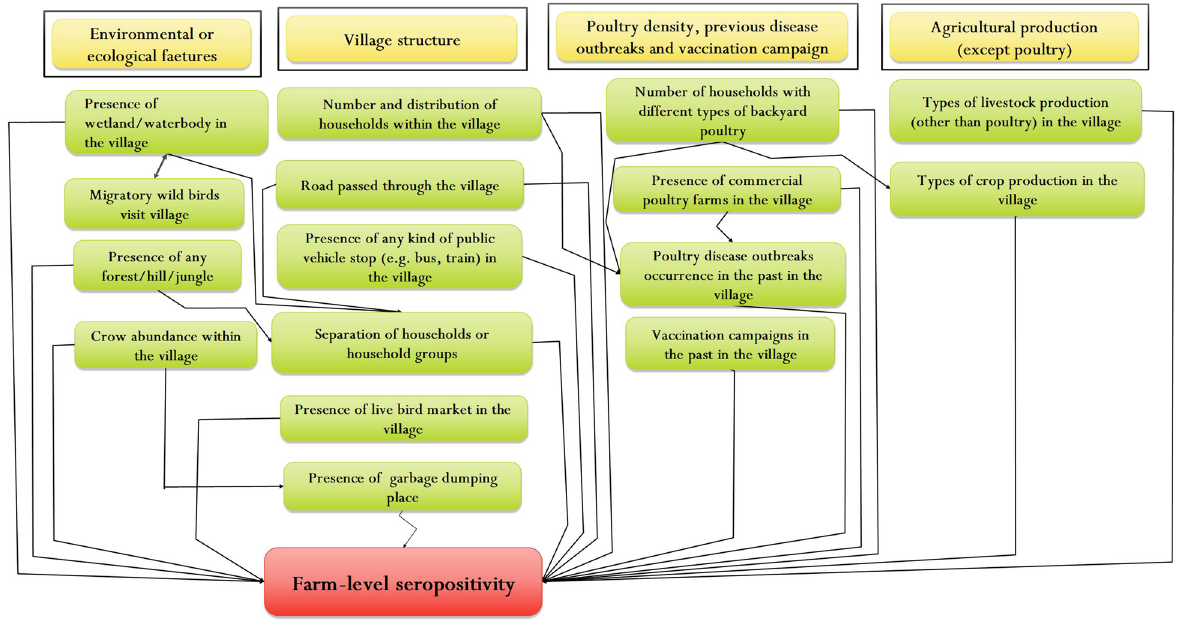
Figure 2. Hypothesized causal pathways for village-level risk factors (green boxes) associated with avian influenza farm-level seropositivity (red box) in backyard chickens in Bangladesh. Yellow headings represent themes or categories under which risk factors can be combined. The causal pathways were used to inform the development of questions used in the interviews with backyard farmers and guided the inclusion of potential confounders and interactions in the final multi-variable